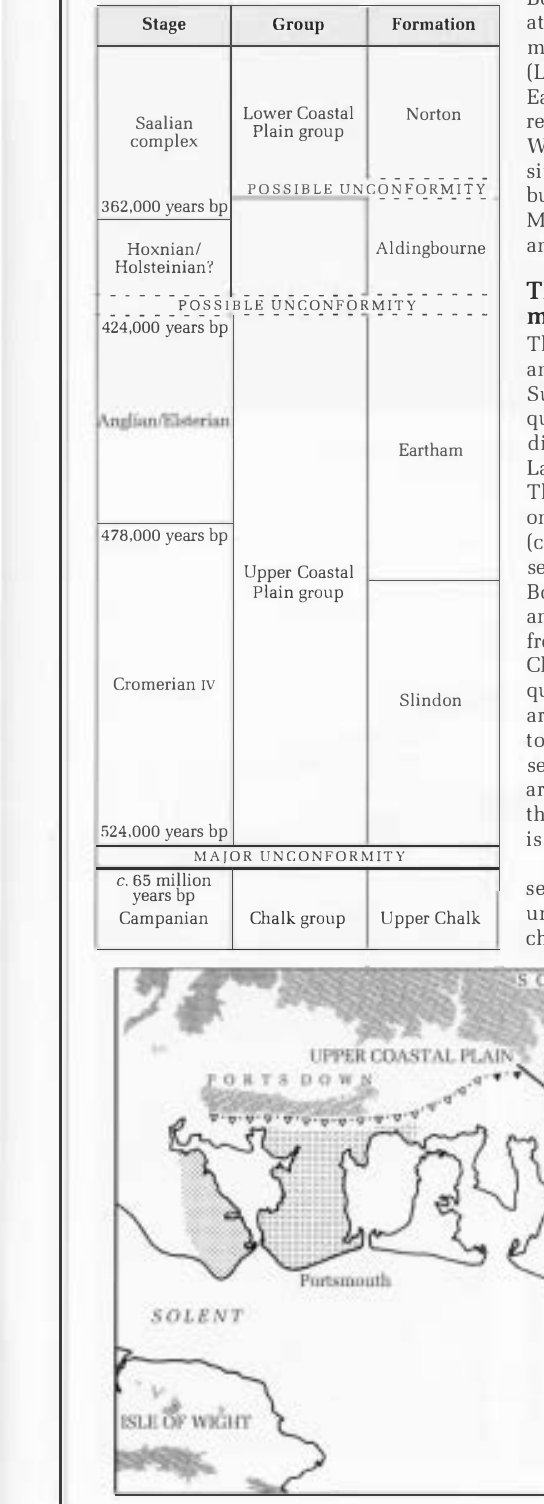
Table 1 Lithostratigraphy and chrono­ stratigraphy in years before present (bp) of the Middle Pleistocene and Upper Creta­ ceous deposits of the West Sussex coastal plain in the Boxgrove area (not to